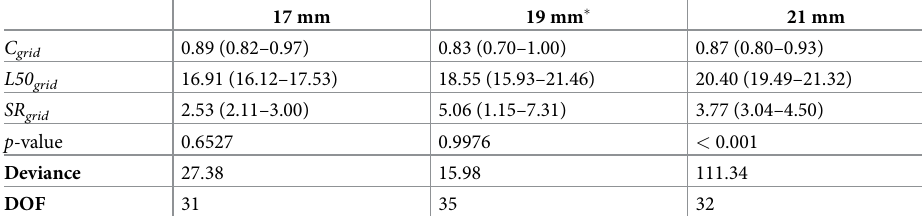
Table 3. Selectivity parameters and fit statistics for cod describing the grid passage probability for the three dif- ferent grids considered in this